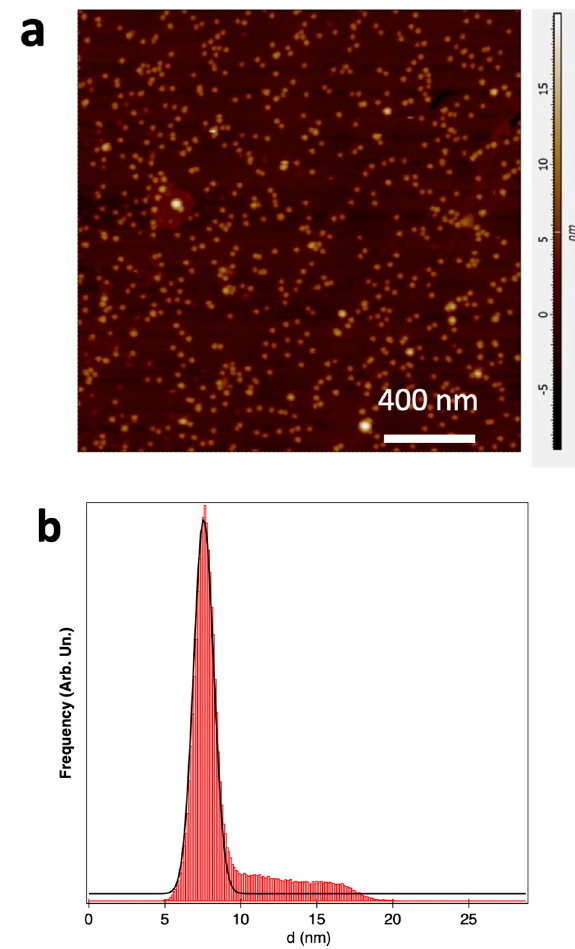
Figure 6. ( a ) AFM topography image of Cu NPs deposited on quartz, with nominal thickness t = 0.36 nm. The fractional coverage C was not measured, because of the limited lateral resolution of the AFM technique; ( b ) vertical height distribution of Cu NPs obtained via a grain analysis of image a (red histogram) and fitting curve (black line).